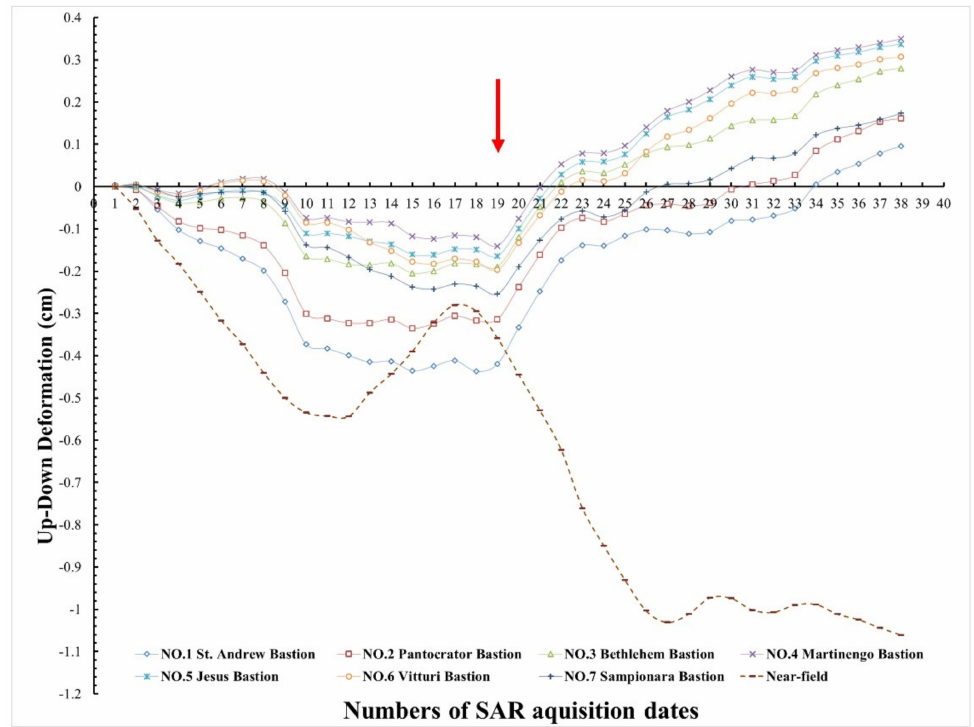
Figure 11. The UD accumulative deformation of the 7 bastions of the HCW and the epicenter. Positive value means